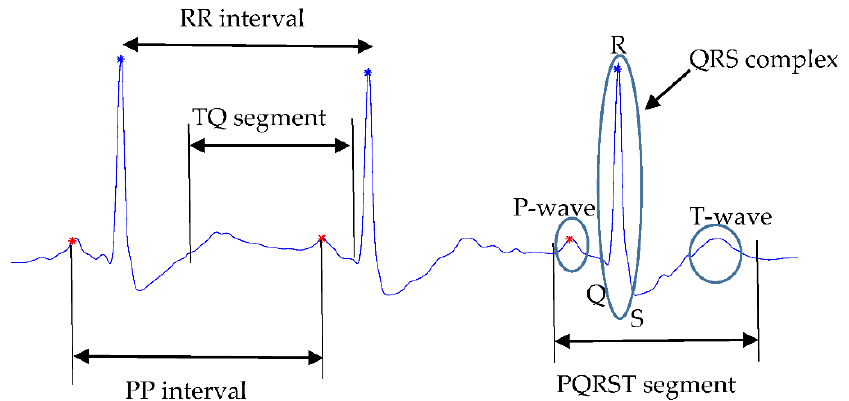
Figure 1. Basic designations for ECG signals interpretation—P-, Q-, R-, S-, T-waves; PQRST-segment, QRS complex, RR interval, PP interval.